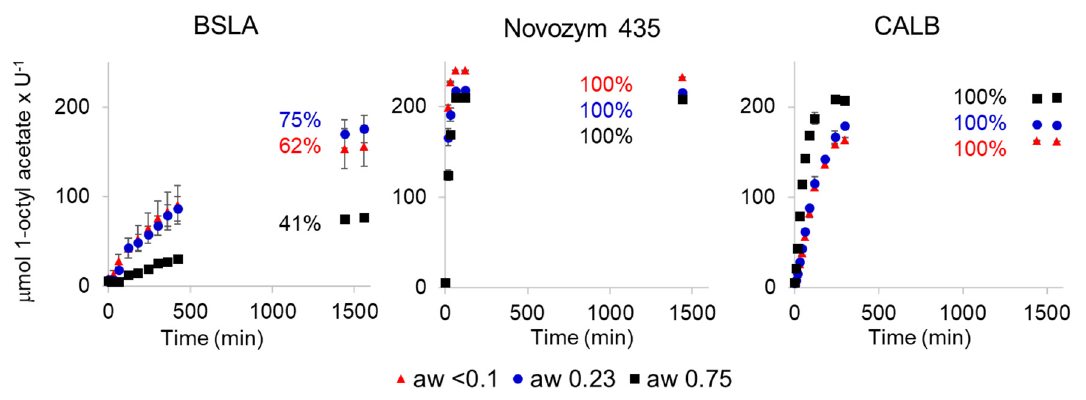
Figure 4. Activity of BSLA, CALB and Novozym 435 in toluene with different a w . U = µmol butyric acid × min − 1 in tributyrin activity assay, 0.5–1.2 U of catalyst, 1-octanol (100 mM), vinyl acetate (5 eq.), ISTD: Decane (500 mM), 1 mL reaction volume, 24 h, 30 °C and 1000 rpm. Blanks were performed in the absence of enzyme and showed no conversion. Final conversions are given as inset; the color corresponds to the a w .